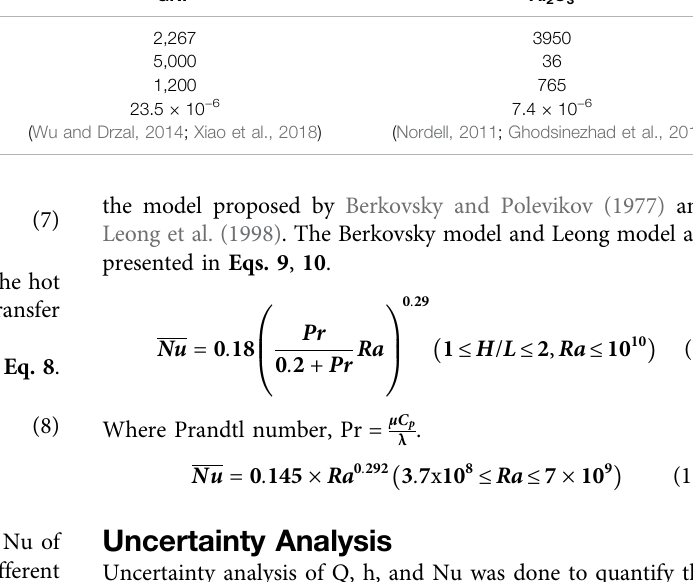
TABLE 1 | Values of the density, speci fi c heat capacity, and coef fi cient of thermal expansion of distilled water and GNP.